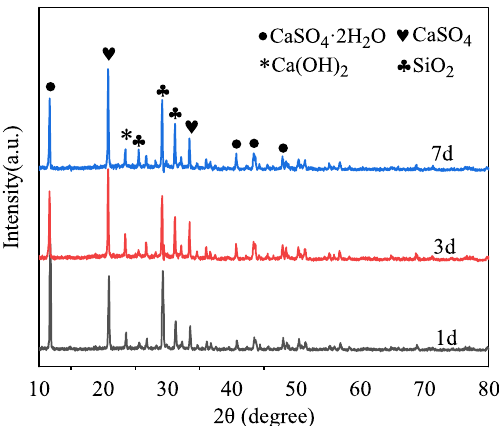
Figure 10. Influence of MSWI fly ash dosage on crystal dosage in